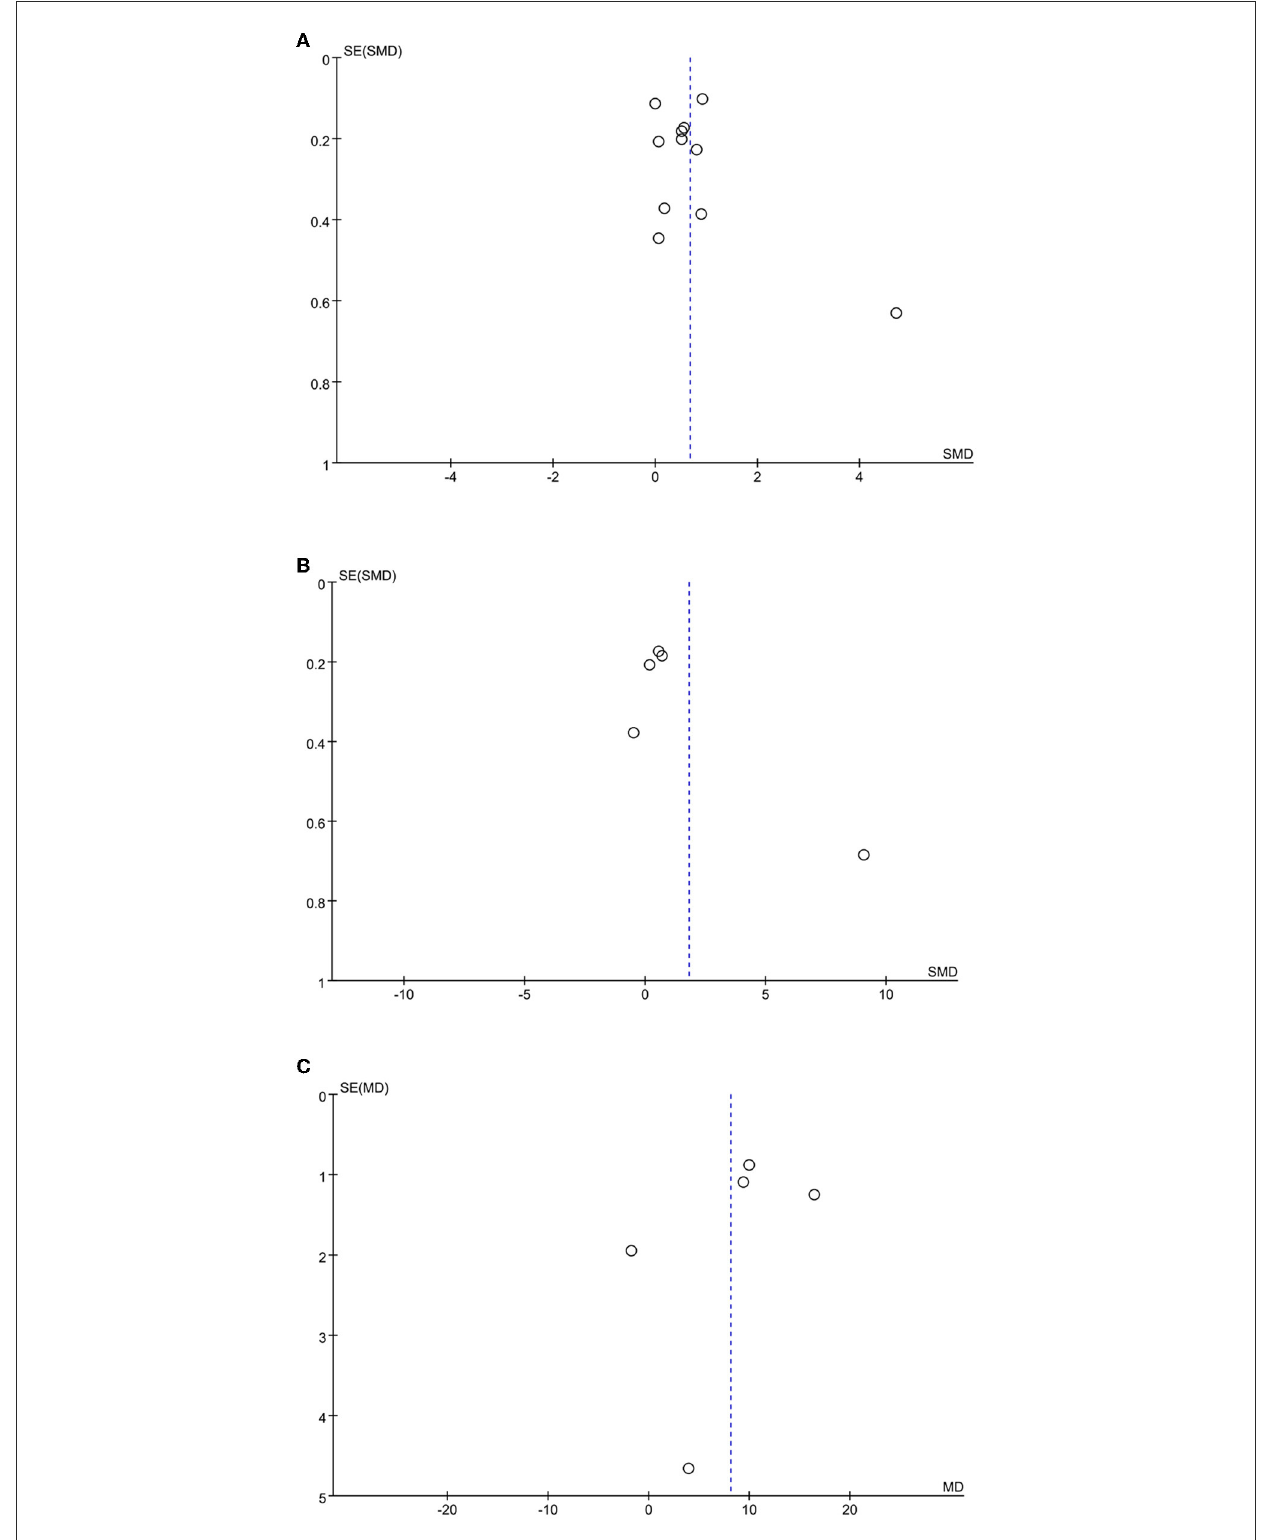
FIGURE7 Funnel plot of the included studies. (A) cognitive function; (B) motor function; (C) activities of daily living.